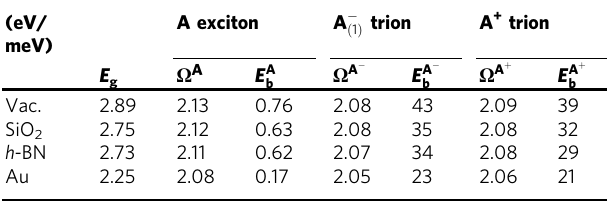
For the A exciton and the A (cid:1) ð 1 Þ and A + trions on different substrates, we give the bandgap E g , transition energies Ω , binding energy de fi ned as E A b ¼ E g (cid:1) Ω A and E A energies are extrapolated for an in fi nite supercell size and an in fi nite k -space coverage for the BSE k -points,i.e., N → ∞ in N × N ×1.Trion-bindingenergiesaregiveninmeV,allothervaluesin